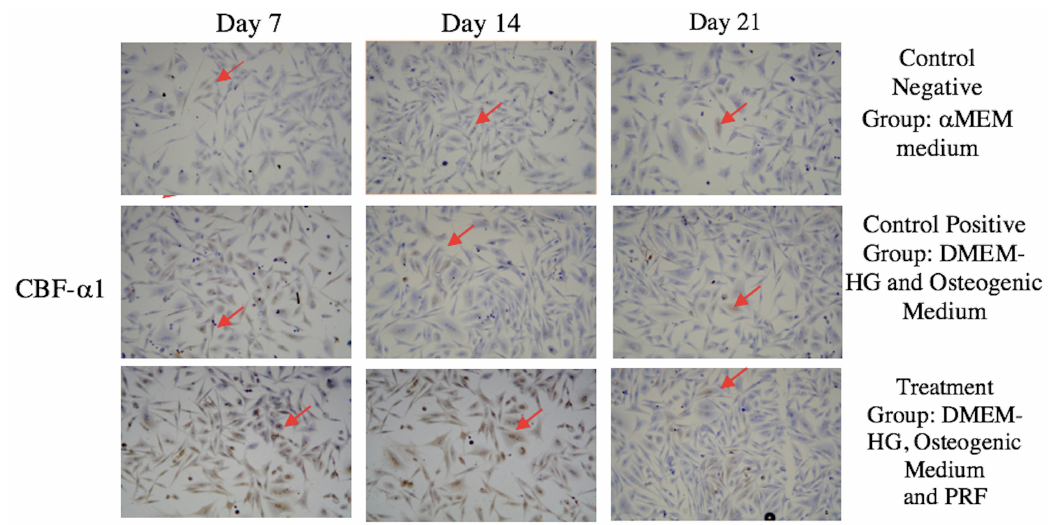
Figure 1. Core-binding factor subunit- α1 (CBF- α 1) expression in gingival stromal progenitor cells (GSPCs) of Wistar rats ( Rattus Novergicus ). (A-C) CBF- α 1 expression in the negative control group; (D-F) CBF- α 1 expression in the positive control group; (G-I)